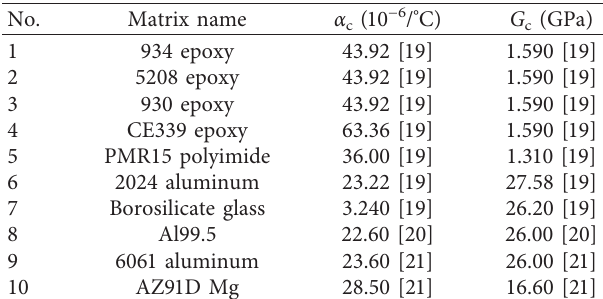
Table 1: Axial shear modulus ( G c ) and axial CTE ( α c ) of common matrix